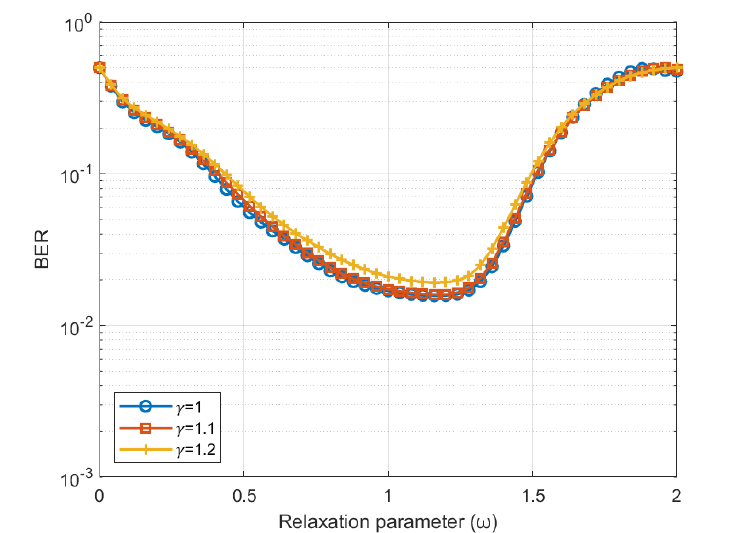
Figure 2. BER performance of CAOR method against γ with SNR = 40 dB, N R × N T = 64 × 16, and number of iterations i = 4.